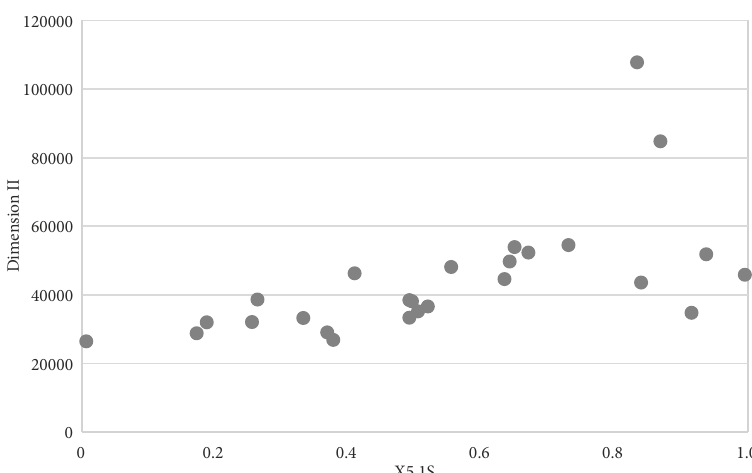
Figure 3. The correlation coefficients between synthetic measure estimated for the third dimension and real GDP per capita ( X 5.1 S ) for Belgium and